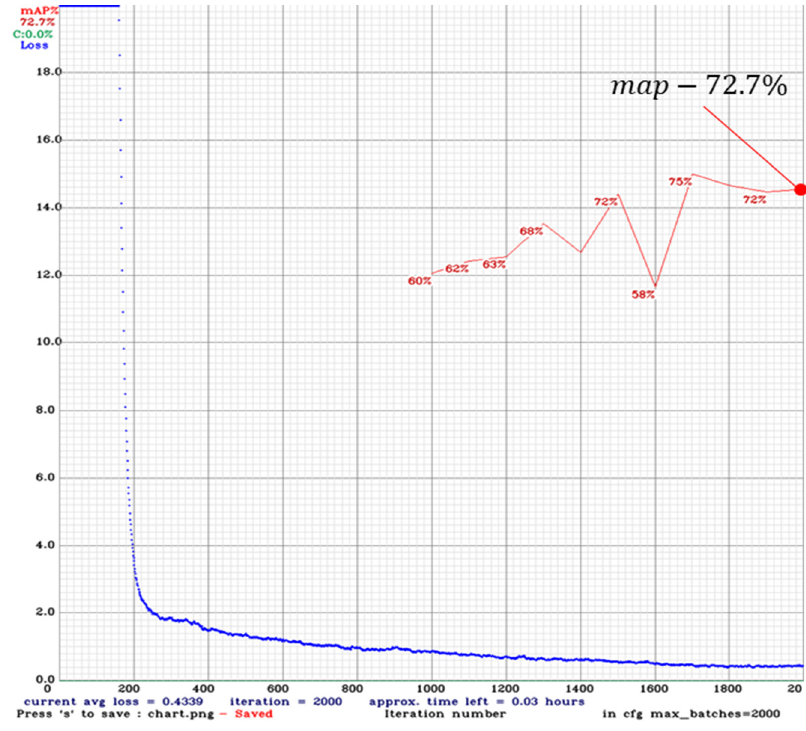
Figure 8. YOLOv3 training gragh.